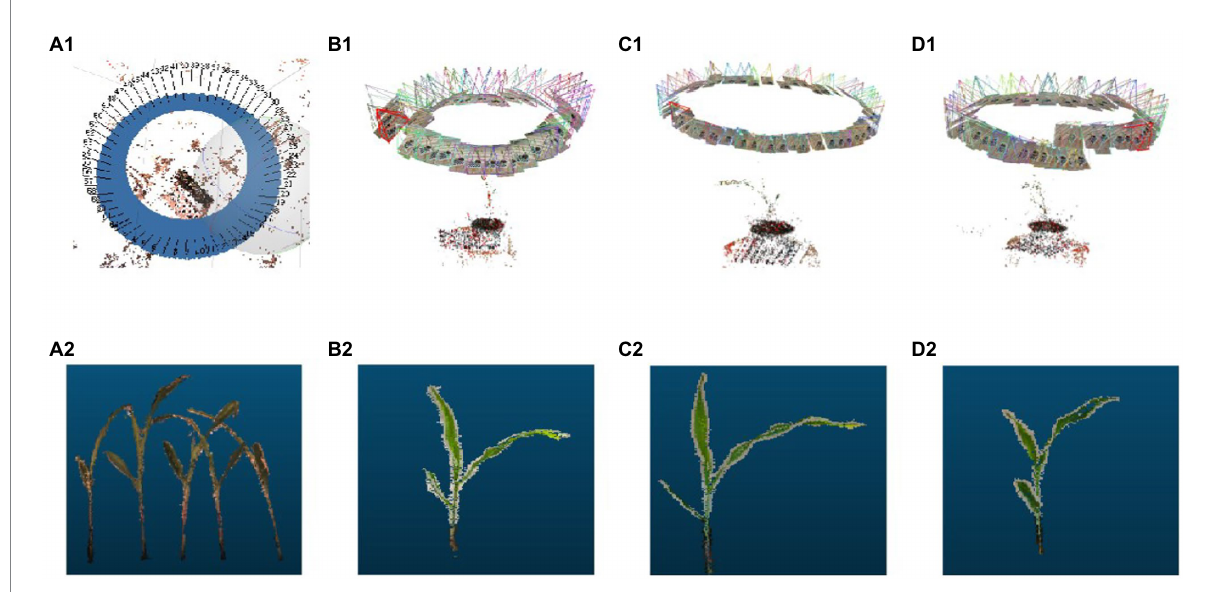
FIGURE 3 3D point cloud reconstruction process. (A1) The point cloud sparse reconstruction based on Agisoft Metashape. (B1–D1) 3D point cloud sparse reconstructions based on Visual SfM. (A2–D2) Point cloud extractions of maize seedlings.